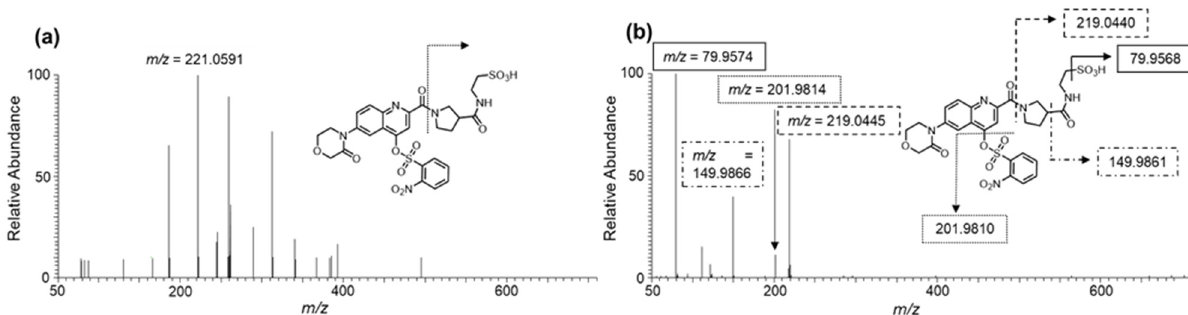
Molecules 2021 , 26 , x FOR PEER REVIEW Figure 4. MS/MS spectra of derivatized amino acids: ( a ) Val, CE 20%; ( b ) Glu, CE 30%; ( c ) Gln, CE30%; and (d ) Arg, CE Figure 4. MS/MS spectra of derivatized amino acids: (a ) Val, CE 20%; ( b ) Glu, CE 30%; ( c ) Gln, CE30%; and (d ) Arg, CE 40%) with Ns-MOK-( S )-Pro-OSu using ESI ( − ) mode. 40%) with Ns-MOK-( S )-Pro-OSu using ESI ( − ) mode.